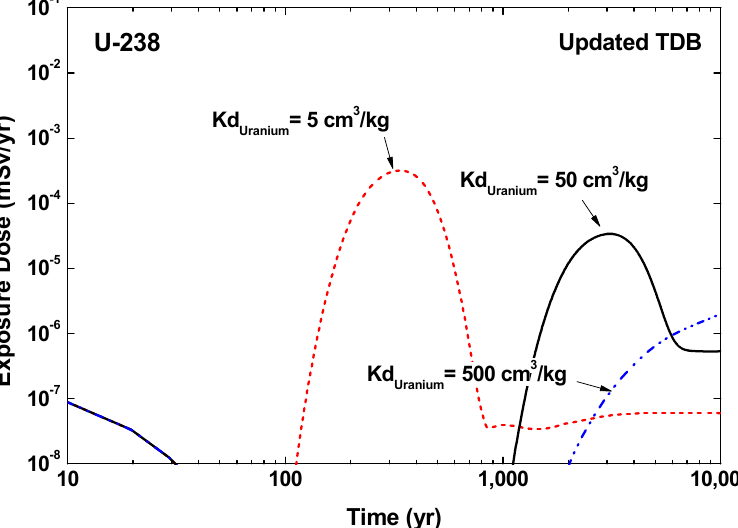
Figure 3. Exposure dose from U-238 calculated with updated TDB at various distribution coefficient (Kd) values.